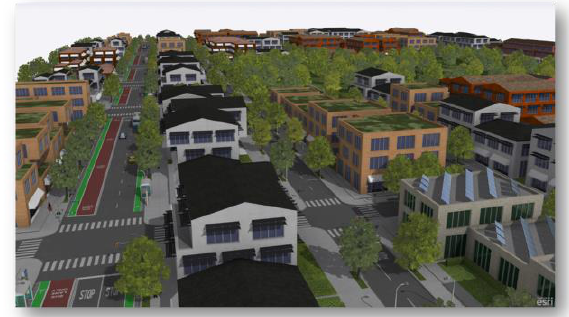
Figure 13. Simulation of the proposed design